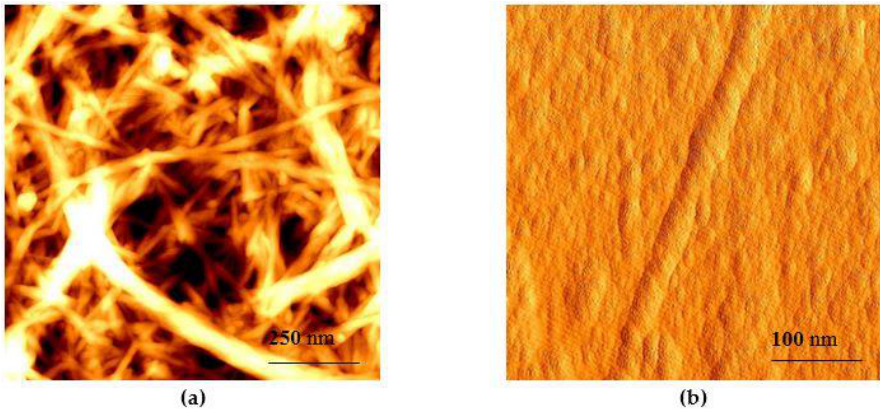
Figure 2. Atomic force microscopy (AFM) pictures of cellulose nanofibers (CNF) obtained from bleached birch Kraft pulp by combined chemical, mechanical and ultrasound treatment ( a ) a bundle of CNF; ( b ) a single fiber of